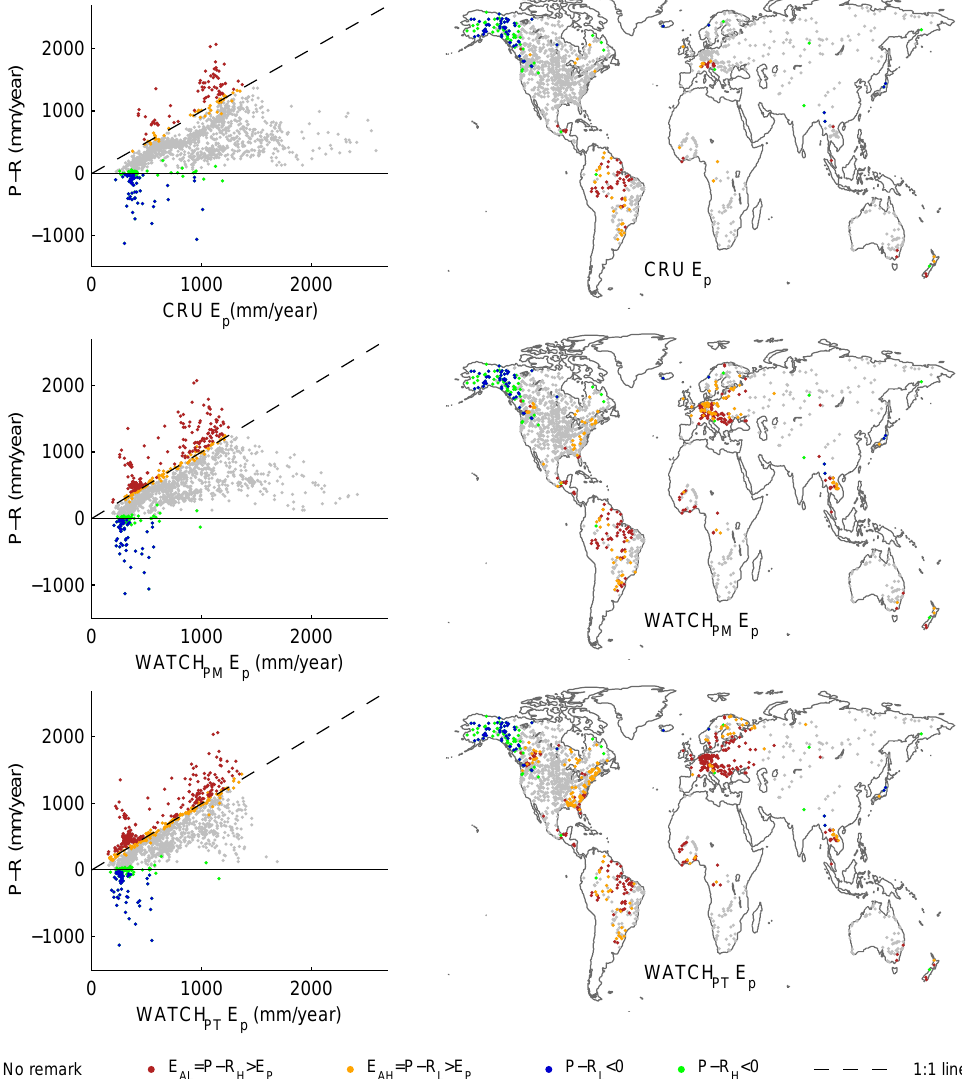
Fig. 9. Mean annual actual evaporation (estimated as P − R using CRU precipitation data) versus potential evaporation from CRU, WATCH Penman–Monteith and WATCH Priestley–Taylor (left panel). Potential evaporation is plotted against actual evaporation estimated using the best runoff estimate, i.e. the y value of each dot represents the best evaporation estimate. The colour coding is based on the high runoff estimate ( R H , giving low estimate of E A ) and low runoff estimate ( R L , giving high estimate of E A ) as indicated in the legend. The right panel shows geographical